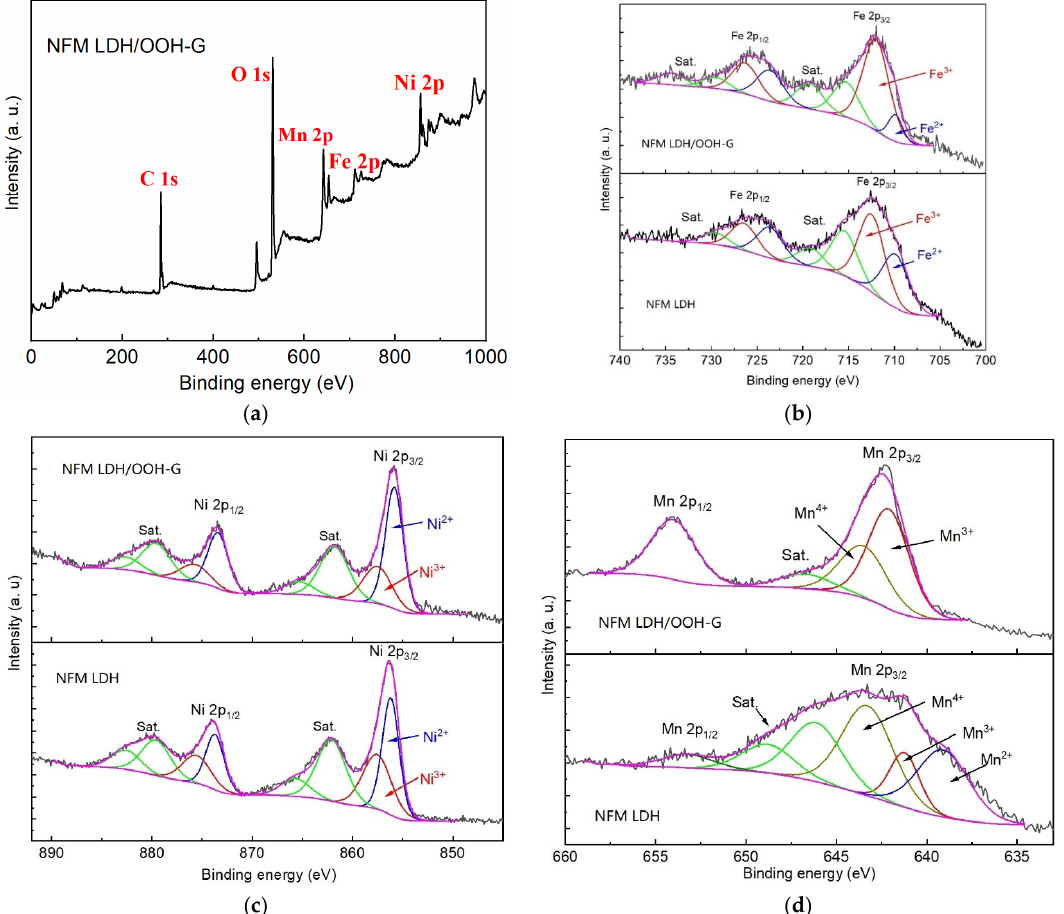
Figure 4. X-ray photoelectron spectrum of ( a ) NFM LDH/OOH-G and high-resolution spectra of ( b ) Figure 4. X ‐ ray photoelectron spectrum of ( a ) NFM LDH/OOH ‐ G and high ‐ resolution spectra of ( b ) Fe, ( c ) Ni (C), ( d ) Mn for NFM LDH (lower) and NFM LDH/OOH ‐ G (upper), respectively. Fe, ( c ) Ni (C), ( d ) Mn for NFM LDH (lower) and NFM LDH/OOH-G (upper),